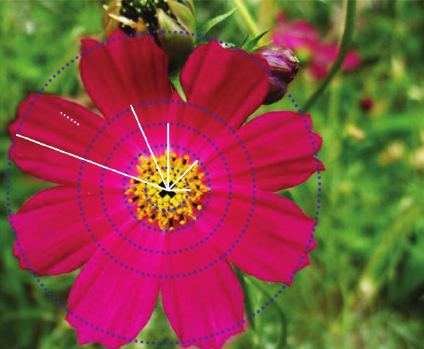
Figure 2: Rotation radius estimation. Given an identified center, rotation radius can be estimated as the maximum value of all extreme value points of radius.